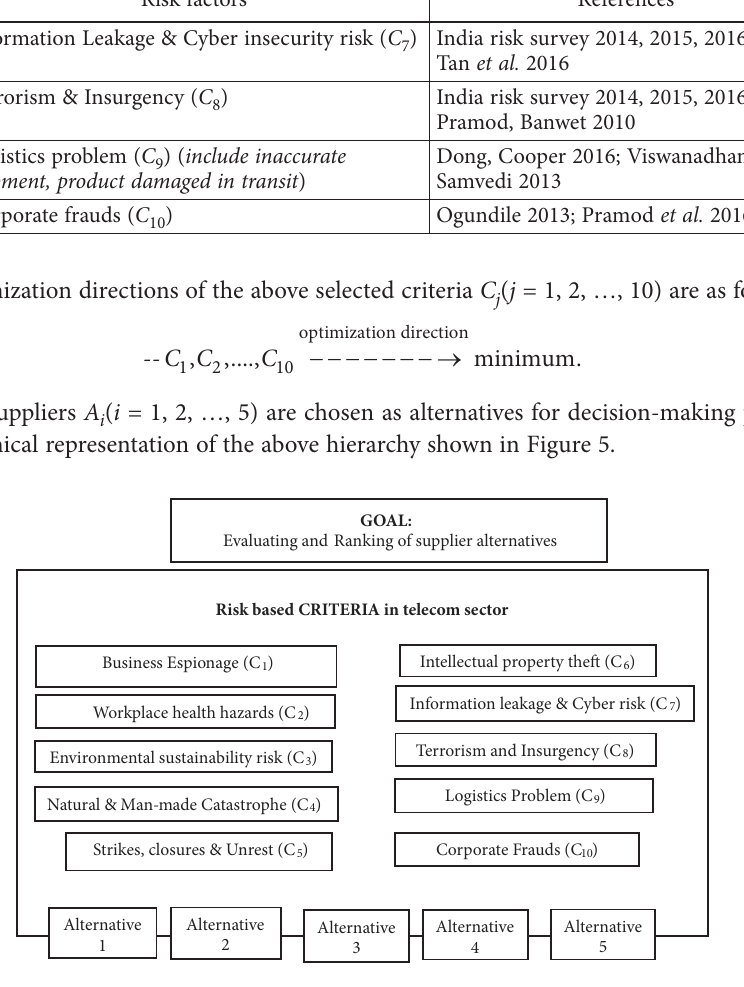
Figure 5. Hierarchical structure for evaluating and ranking the supplier